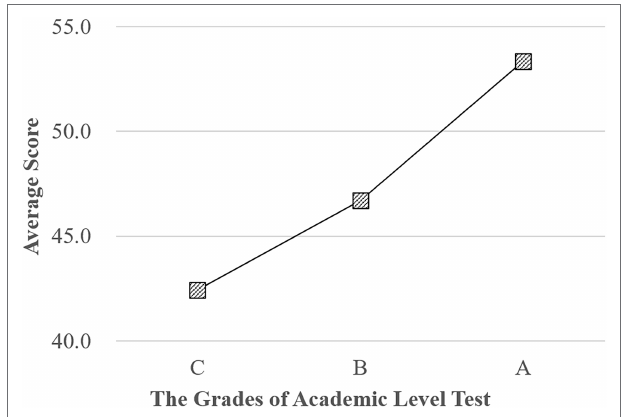
FIGURE 9 | The relationship between the EICD test CTT scores and the grades of the Academic Level Test. The ordinate is the average score in the EICD test(formal) of the students who obtained the A, B, or C grade.